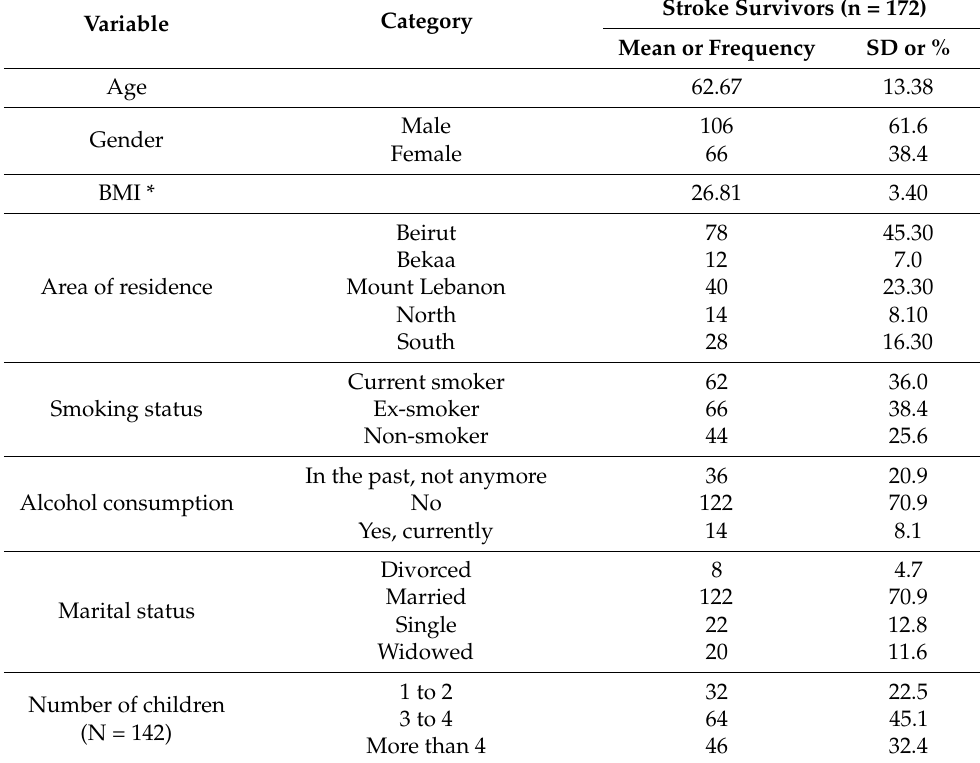
Table 1. Sociodemographic and socioeconomic characteristics of the